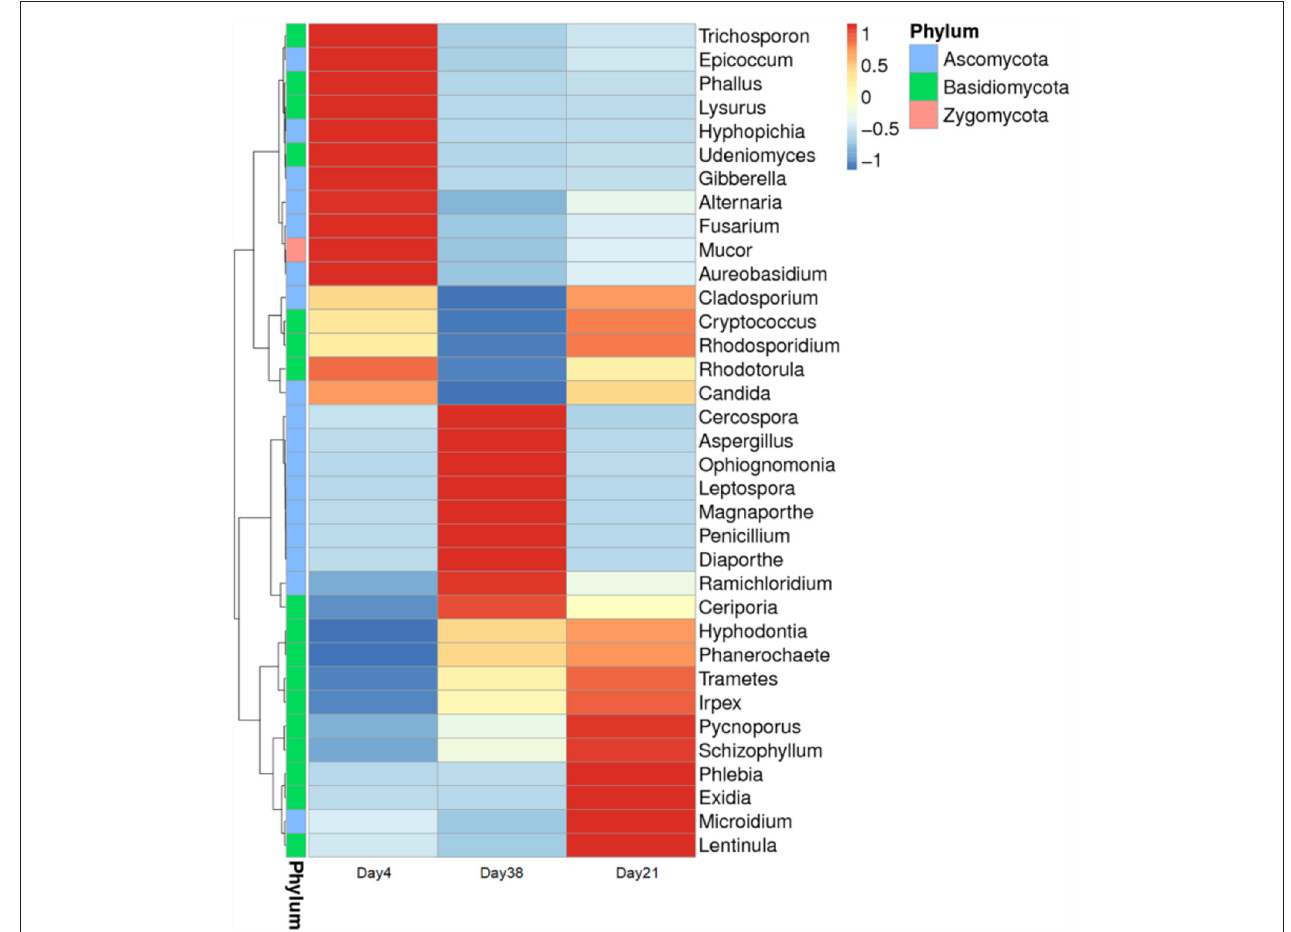
FIGURE 6 | Clustering map of the fungal community species abundances at the genus level in the poultry houses at different broiler chicken growth stages. The sample information is shown crosswise, and the species annotation is shown lengthwise. The species cluster tree is shown on the